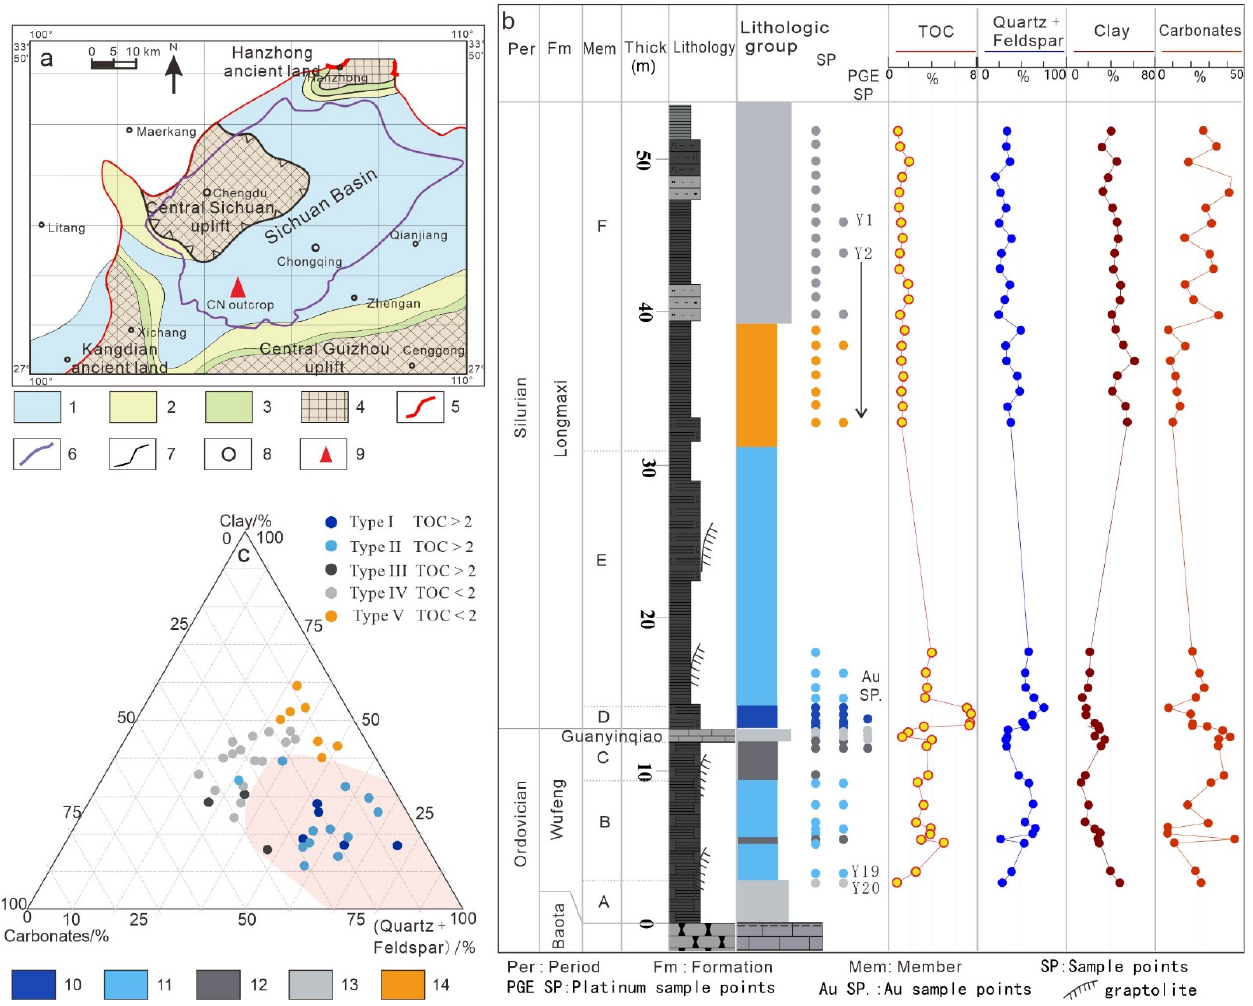
Figure 2. ( a ) The sedimentary facies map of the Wufeng Fm and Longmaxi Fm and outcrop location in the Upper Yangtze Craton. ( b ) Stratigraphic column of the Wufeng Fm and Longmaxi Fm and the sampling location; ( c ) Ternary diagram of mineral composition of Wufeng and Longmaxi black shale. 1. Deep water shelf facies; 2. Shallow water shelf facies; 3. Tidal-flat facies; 4. Ancient land or uplift; 5. Fault; 6. Basin boundary line; 7. Sedimentary facies boundary; 8. Place name; 9. Sampling location; 10. Type I: Siliceous carbonaceous shale, TOC > 2%; 11. Type II: Calcareous siliceous shale, TOC > 2%; 12. Type III: Calcareous carbonaceous mudstone TOC > 2%; 13. Type IV: bioclastic calcareous mudstone and calcareous silty mudstone, TOC < 2%; 14. Calcareous silty mudstone and argillaceous siltstone, TOC <